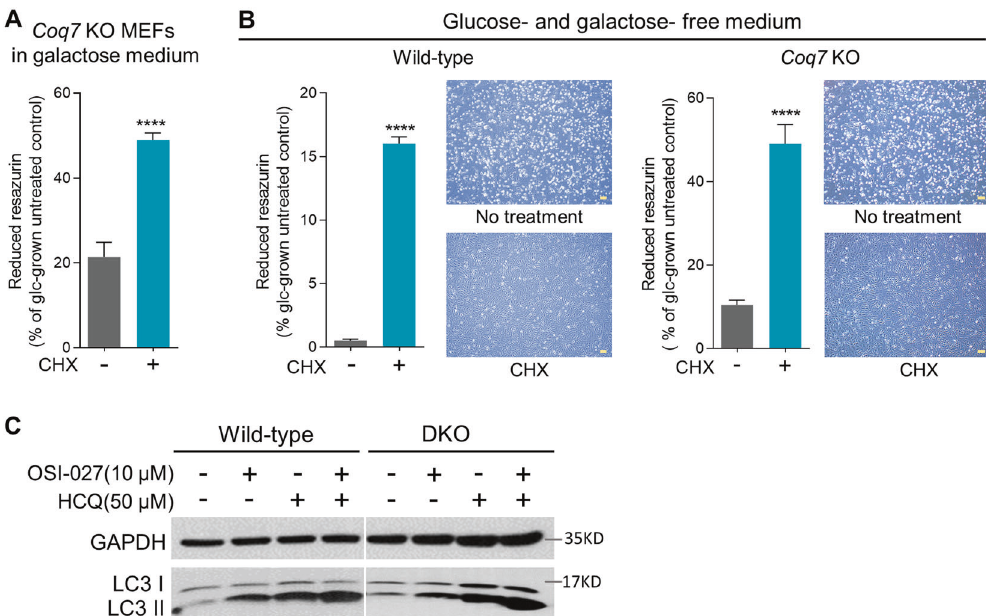
Fig. 6 Protective effect of cycloheximide (CHX) on cell death induced by glucose withdrawn. A Cell viability measurement of Coq7 KO cells after 4 days of culture in galactose medium. B Viability measurement of wild-type or Coq7 KO cells after 2 days of culture in the sugar-free medium. Resazurin assay was used for determining cell viability with the results presented as relative to glucose-grown control cells. Error bars represent SEM ( n = 4). CHX: 3 µM. **** p < 0.0001 (one-way ANOVA followed by Tukey ’ s multiple-comparison test). C Western blot of LC3 protein in wild-type and DKO MEFs after 2 days of indicated treatments. HCQ: hydroxychloroquine. Scale bars = 100